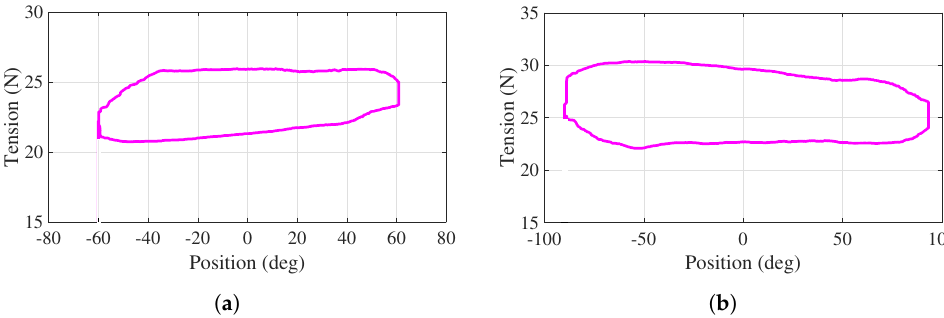
Figure 13. Active phase. Tensions as a function of the angular position for cables ( a ) l 1 , ( b ) l 3